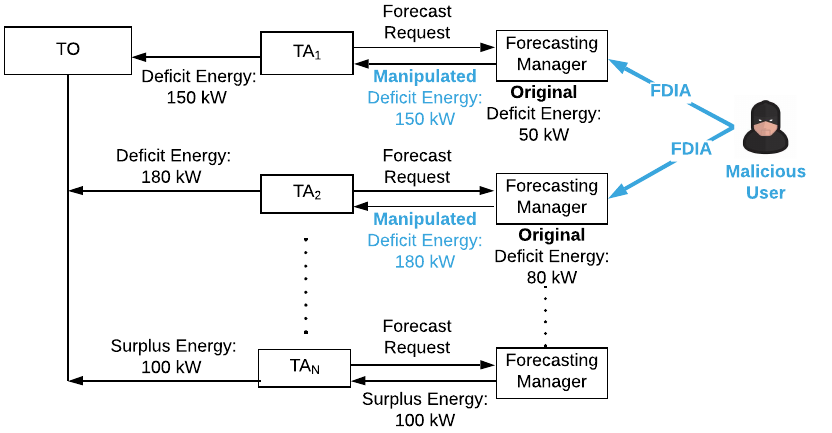
Figure 6. FDIAs through the distributed energy resources (DERs) of TEM by a malicious